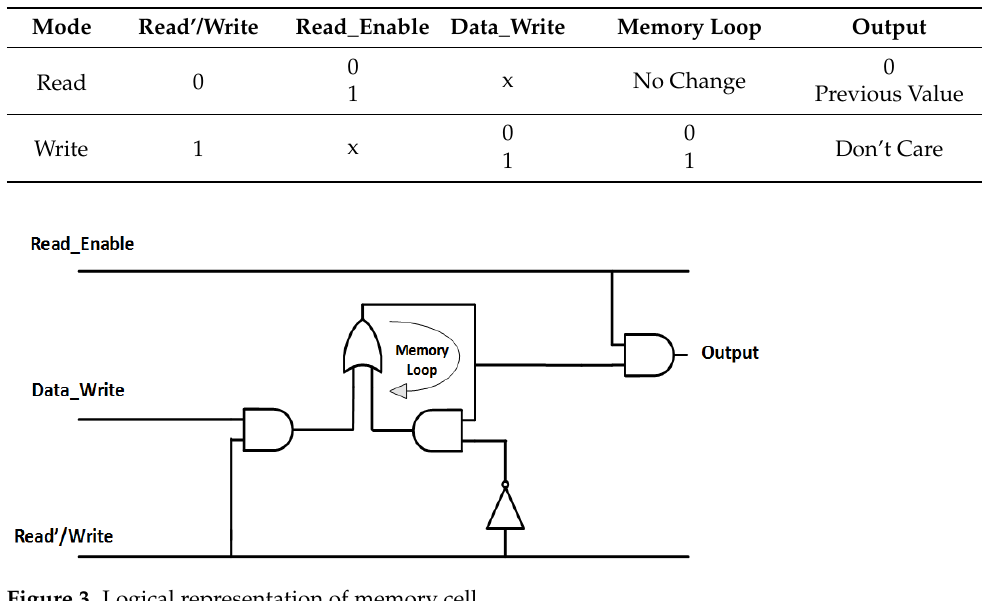
Figure 3. Logical representation of memory cell.